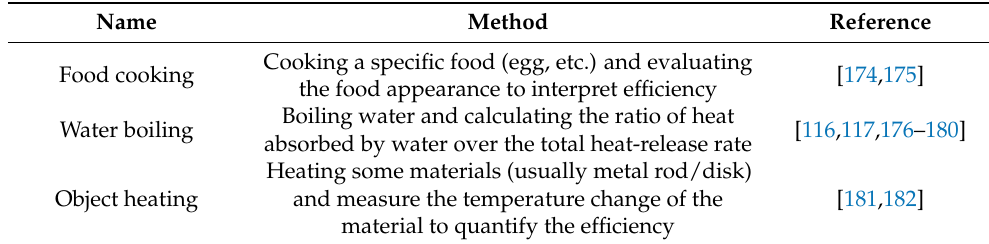
Table 15. Cooking appliance efficiency evaluation